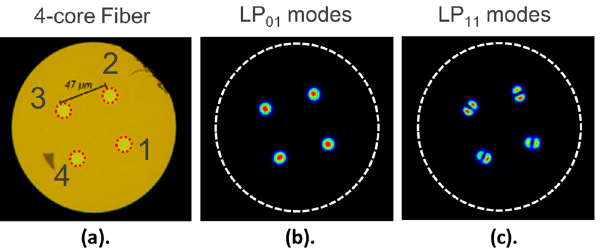
Figure 7. Simultaneous mode multiplexing. ( a ) The 3-mode, 4-core fiber, with the simultaneous multiplexing of all the ( b ) LP 01 and ( c ) LP 11 modes shown at 1550